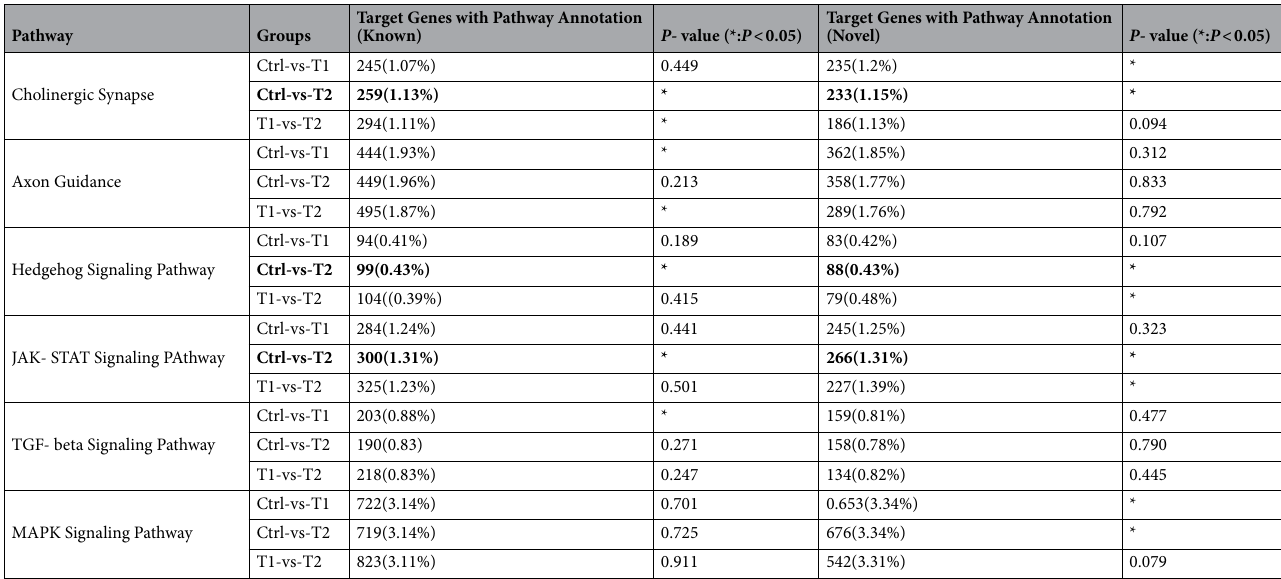
Table 5. The most abundant target genes annotated with the 6 selected pathways differentially expressed in control versus Test1, Control versus Test 2 and Test 1 versus Test 2 groups. Data were extracted after copyright permission from KEGG database and referenced in discussion. Significant values are in